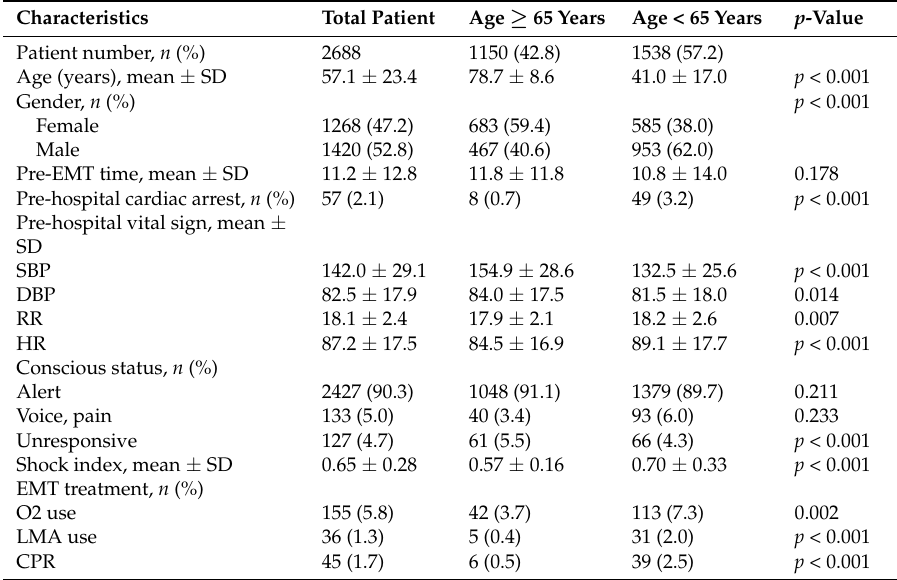
Table 1. Clinical characteristics of the total